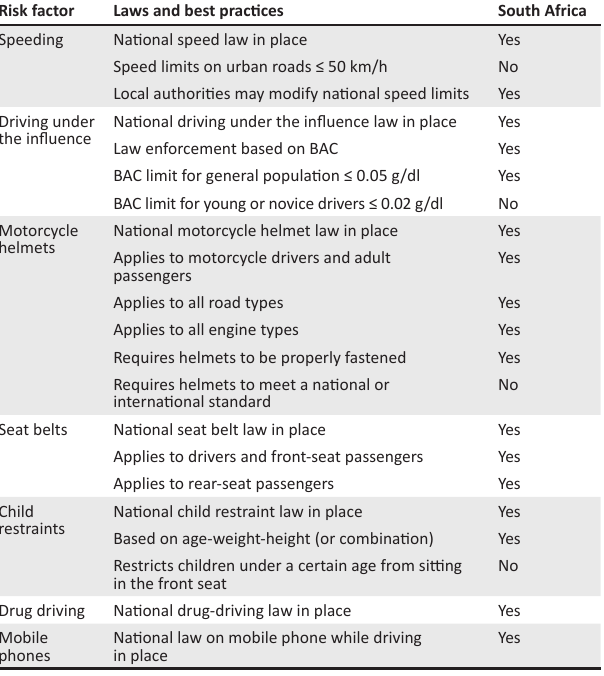
TABLE 1: Road safety risk factors, legislative best practices and South African legislation.